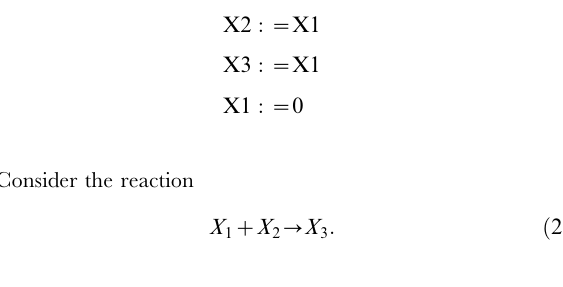
Table 2. Statistical simulation results for ‘‘Multiplier’’ construct.